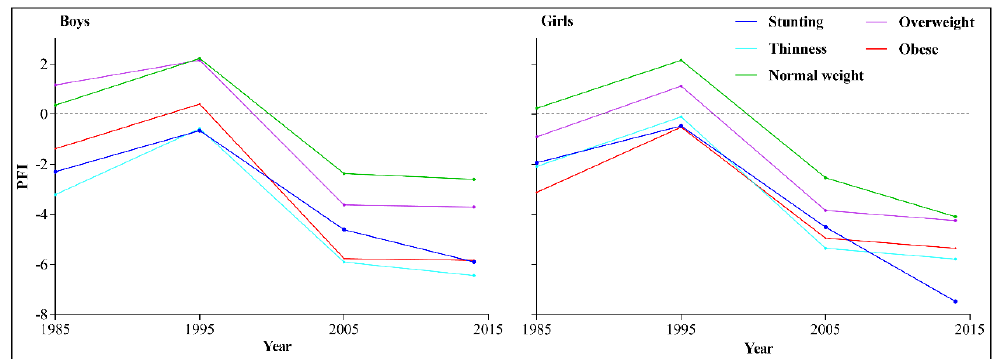
Figure 3. Trend in the physical fitness indicator (PFI) of children and adolescents in Xinjiang, according to nutritional status, 1985 toto